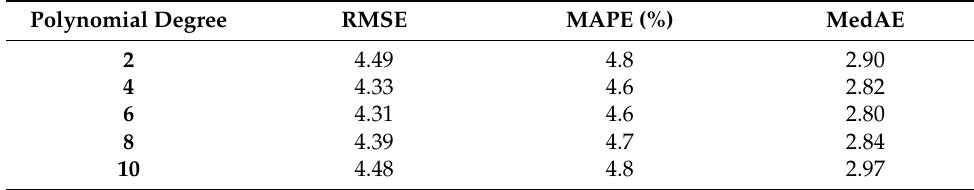
Table 7. Performance of polynomial method under different degrees.